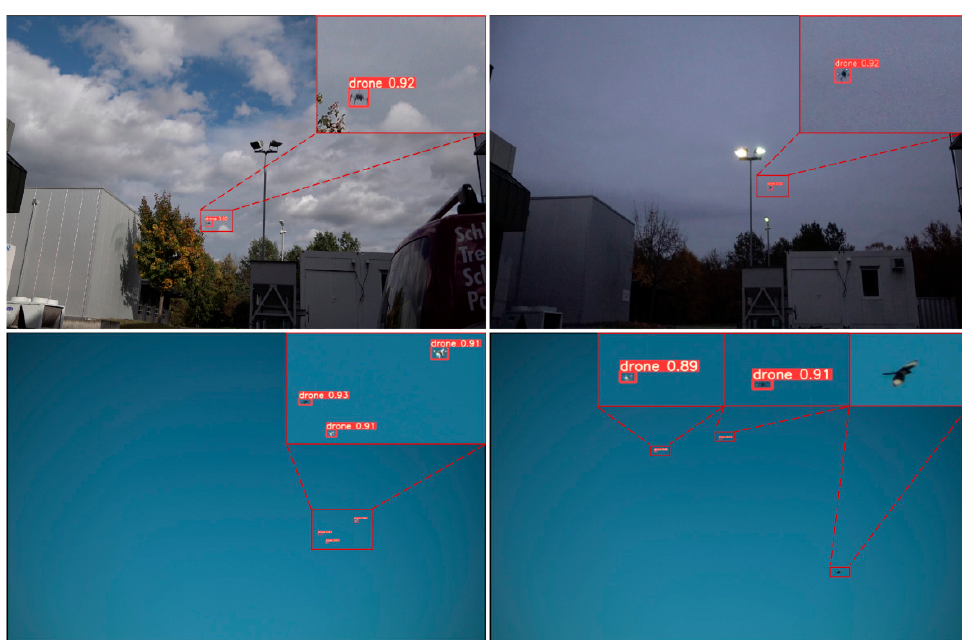
Figure 9. Visual heatmaps of different networks.